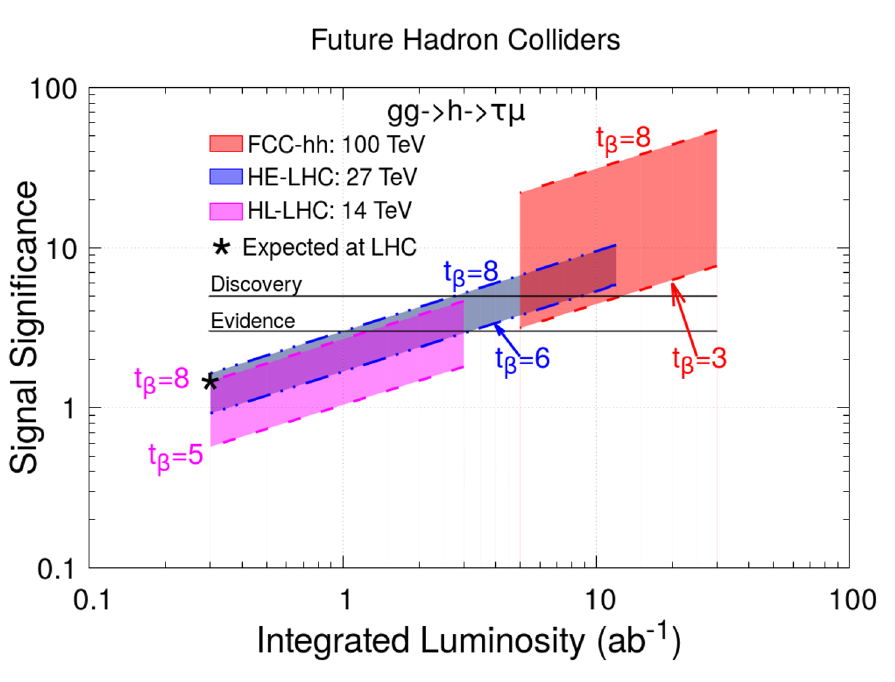
Figure 10 . Signal signi(cid:12)cance as a function of the integrated luminosity for representative values of t (cid:12)